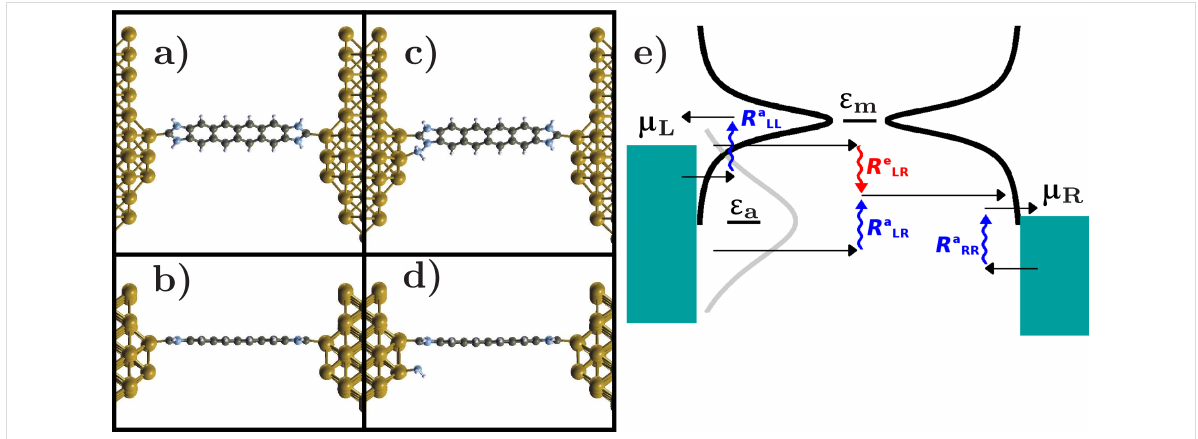
Figure 1: a,b) Front and side view of the NHC attached to clean electrode terminations ( C structure). c,d) Front and side view of the junction in pres- ence of a NH 2 group adsorbed on one side of the junction ( CA structure). e) Schematic illustration of the different emission and absorption processes due to tunneling electrons. The energy ε m represents the state associated to the molecule bridging the two electrodes while ε a is the state of an adsorbate attached to the left electrode. The black curves are the left- and right-projected DOS of the molecule while the gray curve is the density of states of the